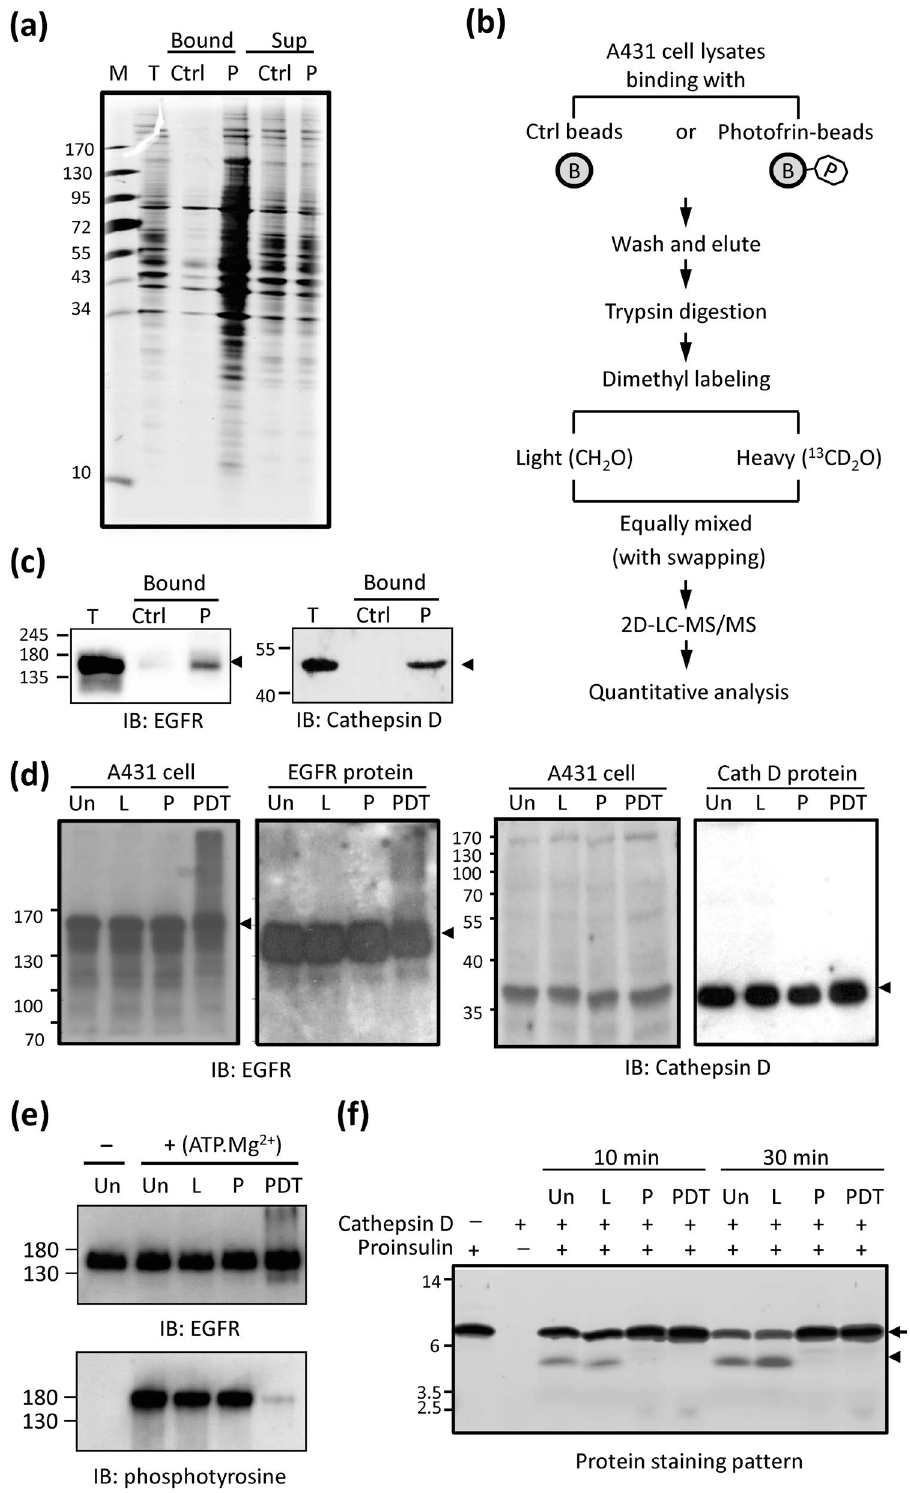
Figure 7. Identification and verification of Photofrin-interacting proteins. ( a ) SDS-PAGE analysis of potential Photofrin-interacting proteins. A431 cell lysates (1 mg of protein) were incubated with Photofrin-coupled beads (P) or control beads (Ctrl), and washed with 1 M NaCl and PBS. The bead-bound proteins (Bound) and the unbound supernatants (Sup) were subjected to SDS-PAGE followed by silver staining. T, total cell lysates. ( b ) The proteomics workflow used to identify potential Photofrin-interacting proteins. See the Materials and Methods for details. ( c ) Samples were processed as described in ( a ), and the bead-bound proteins (Bound) were subjected to SDS-PAGE followed by Western blot analysis with anti-EGFR or anti-cathepsin D antibodies. T, total cell lysates. ( d ) A431 cells or recombinant EGFR (or cathepsin D) proteins were left untreated (Un)